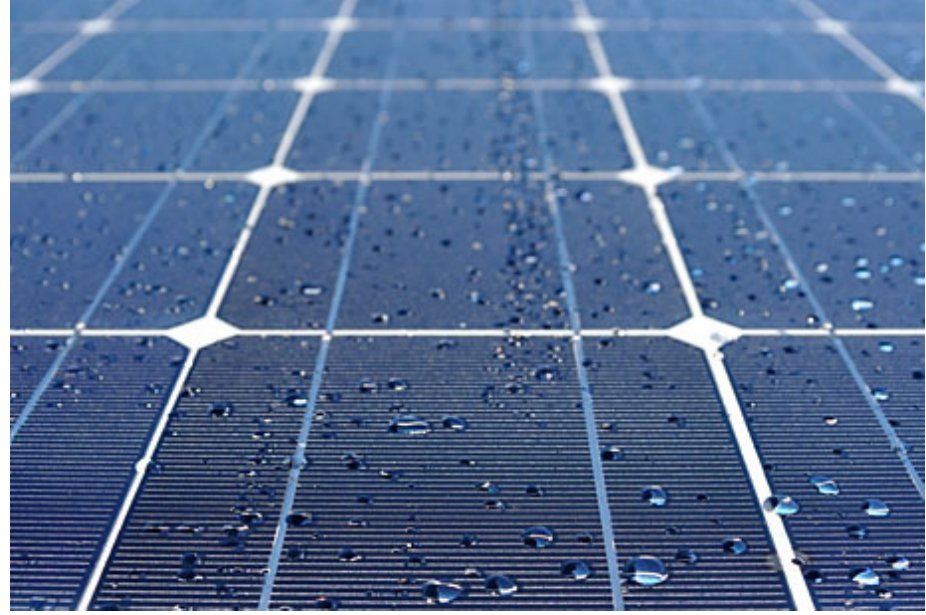
Figure 28. A PV module being cleaned with rain